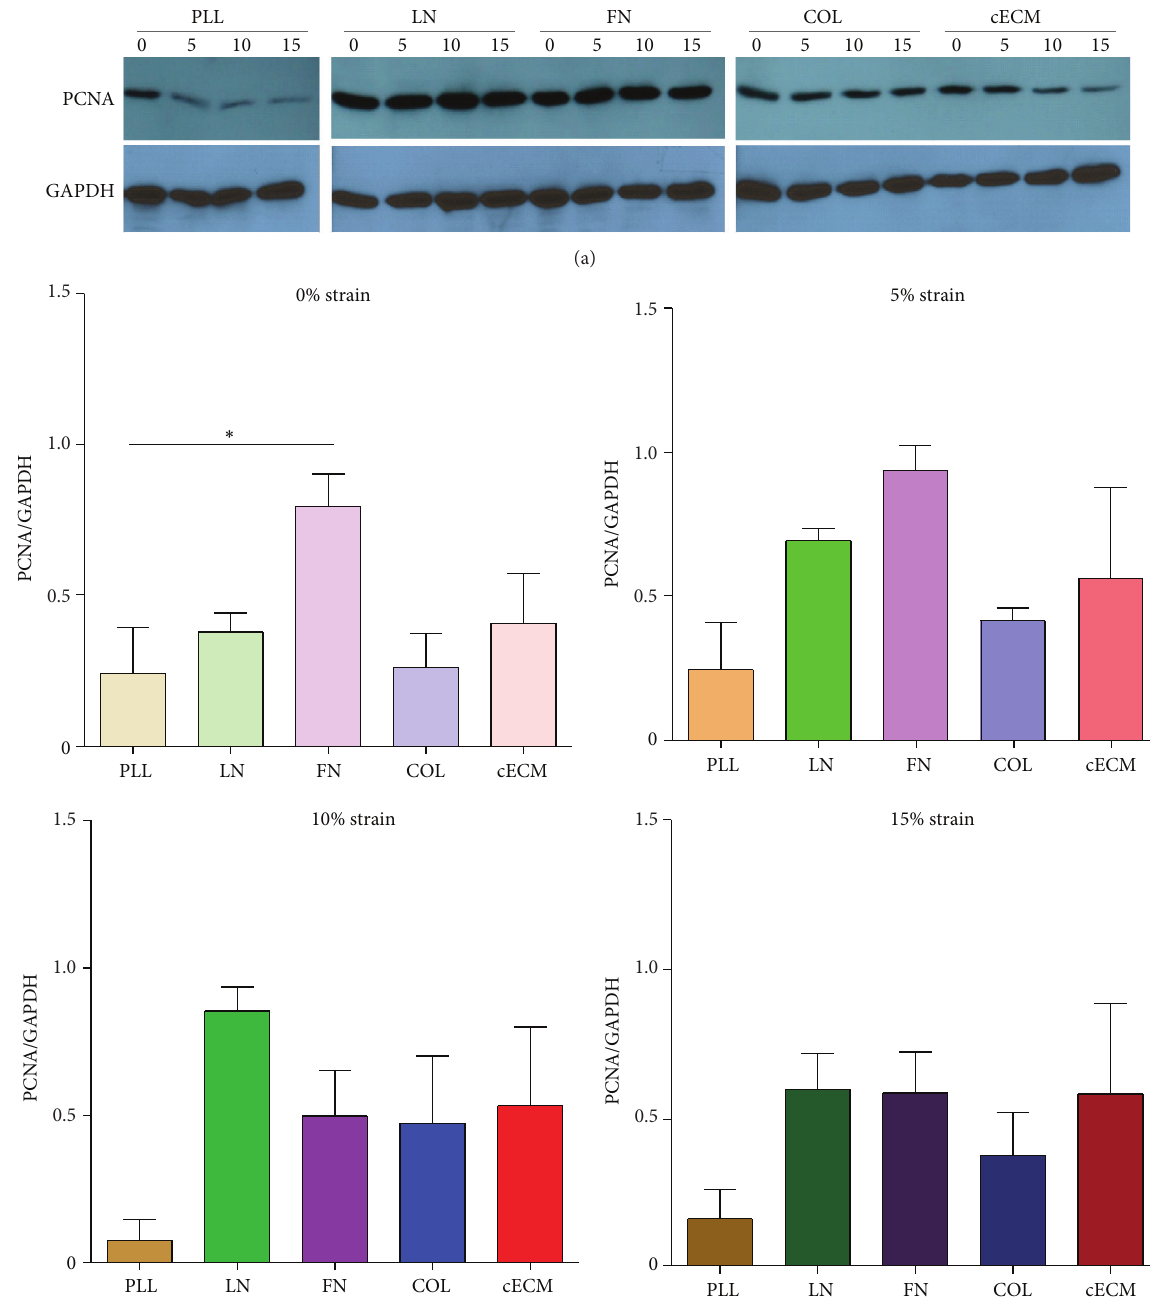
Figure 4: FN induces PCNA expression. CPCs were seeded on each matrix for 6 hours followed by 24 hours of cyclic strain and lysed. Cell lysate was evaluated by western blot. (a) Representative blots. (b) Quantification by densitometry; 𝑛 = 4 -5; PLL (brown): poly-L-lysine, LN (green): laminin, FN (purple): fibronectin, COL (blue): collagen I, cECM (red): naturally derived cardiac extracellular matrix, PCNA: proliferating cell nuclear antigen, and ∗ represents 𝑝 < 0.05 by